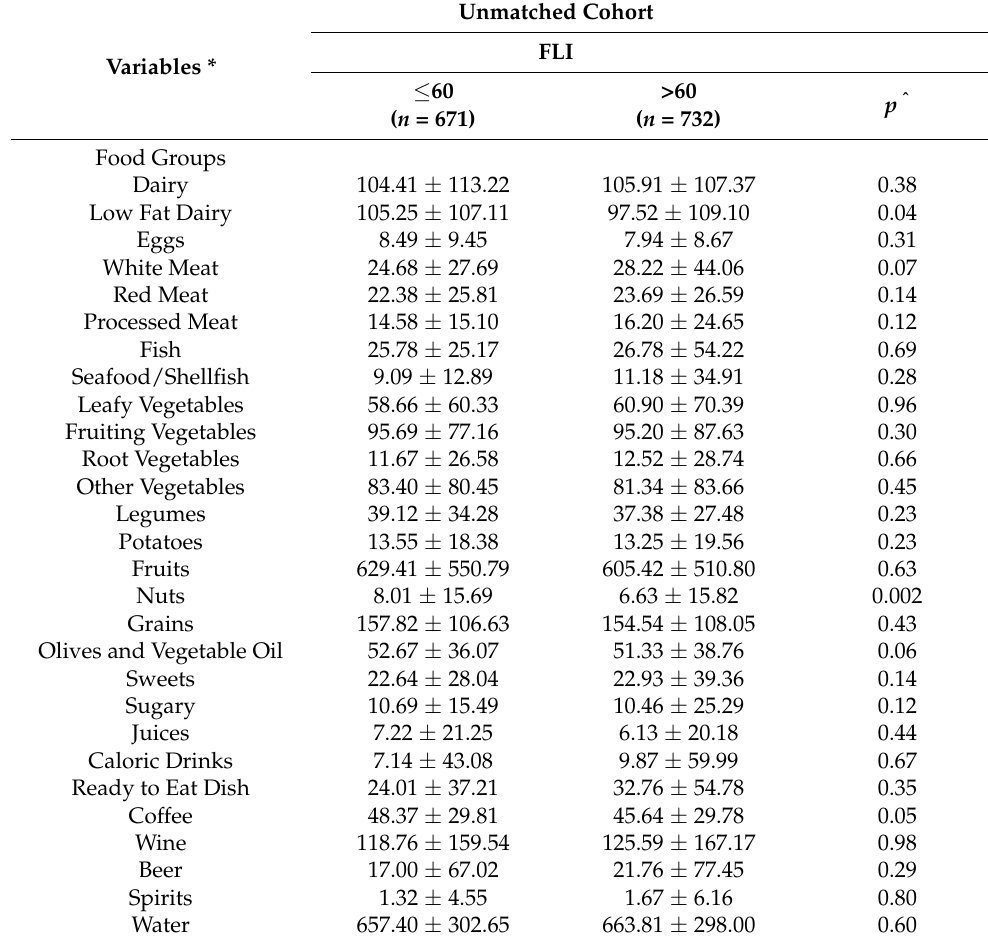
Table 2. Food, micro and macro intake in the unmatched